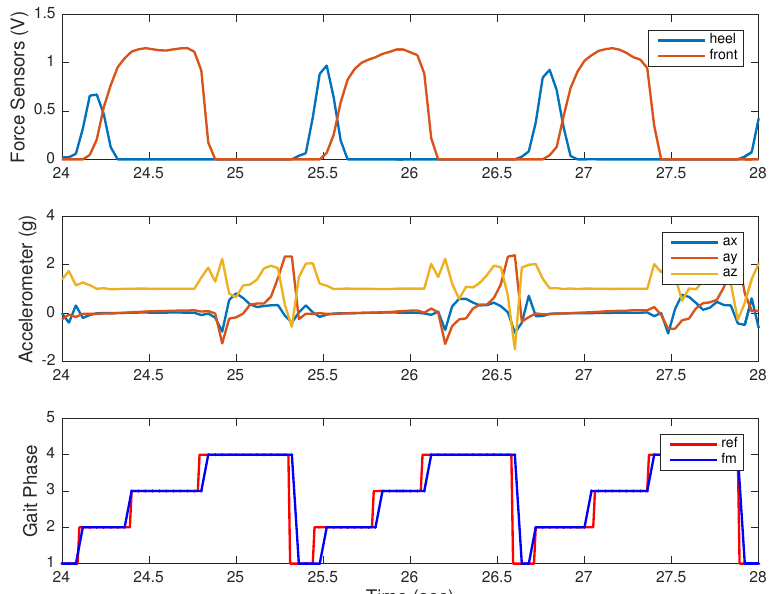
Figure 5. Comparison of our gait phase detection algorithm and the reference gait phase signal. In the top graph, the force value F h and F f are reported. The middle figure reports the calibrated accelerometer components ( ax , ay , az ). In the bottom figure, the reference gait phase signal is reported in red while the signal obtained by FootMoov elaborated with our detection algorithm is reported in blue.